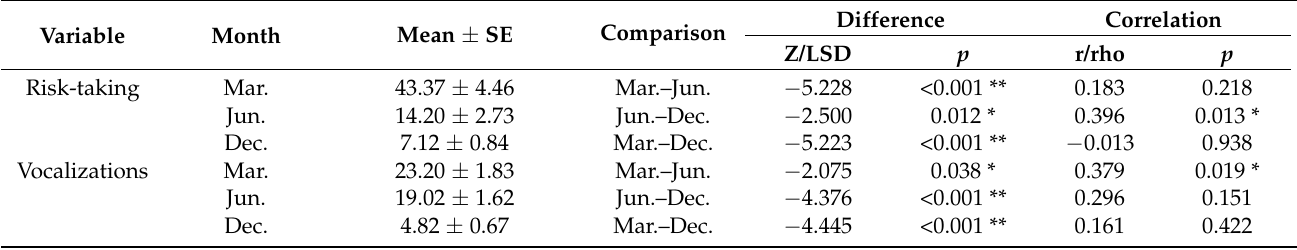
Table 2. Description of the mean differences and correlations of variables in 75 Tibetan sheep ( Ovis aries ) at different stages. Variable